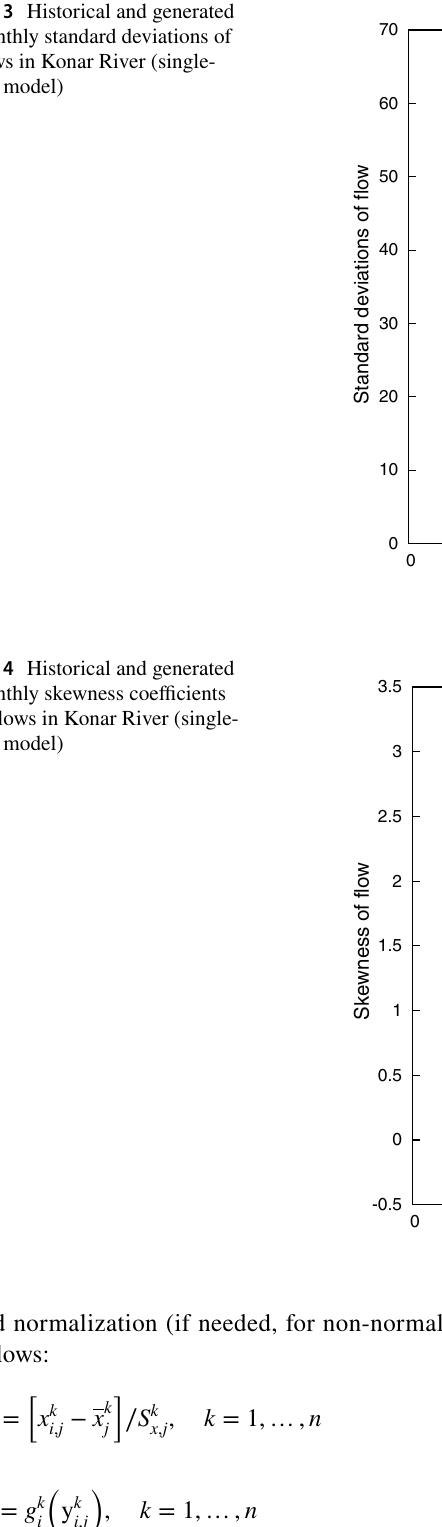
Fig. 3 Historical and generated monthly standard deviations of flows in Konar River (single- site model)